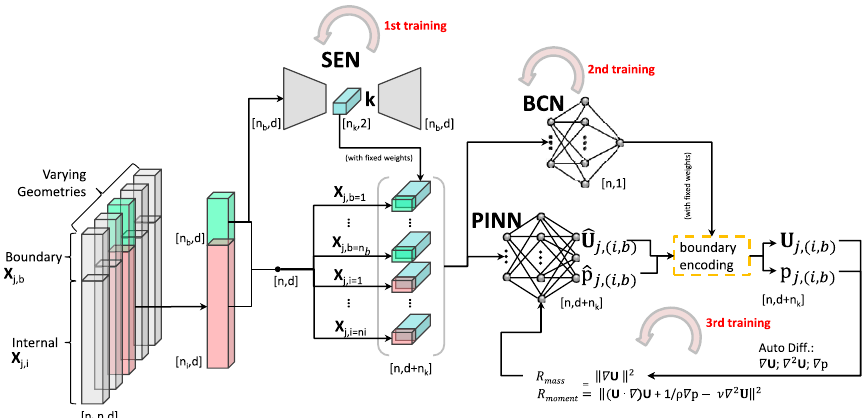
Fig. 1 Schematic description of the architecture of the proposed DNN Method (GAPINN) to generate surrogates of PDEs with irregular non‑parameterized geometries using PINNs. The network consists of three subnetworks which are trained separately. The SEN is a Variational‑Auto‑Encoder type reducing the geometry dimensions to a latent vector k. PINN takes k and spatial positions to solve the PDE and building the surrogate and BCN, by also taking spatial information and k, helps constraining boundary conditions in the PINN. Dimensions at each operation are noted in